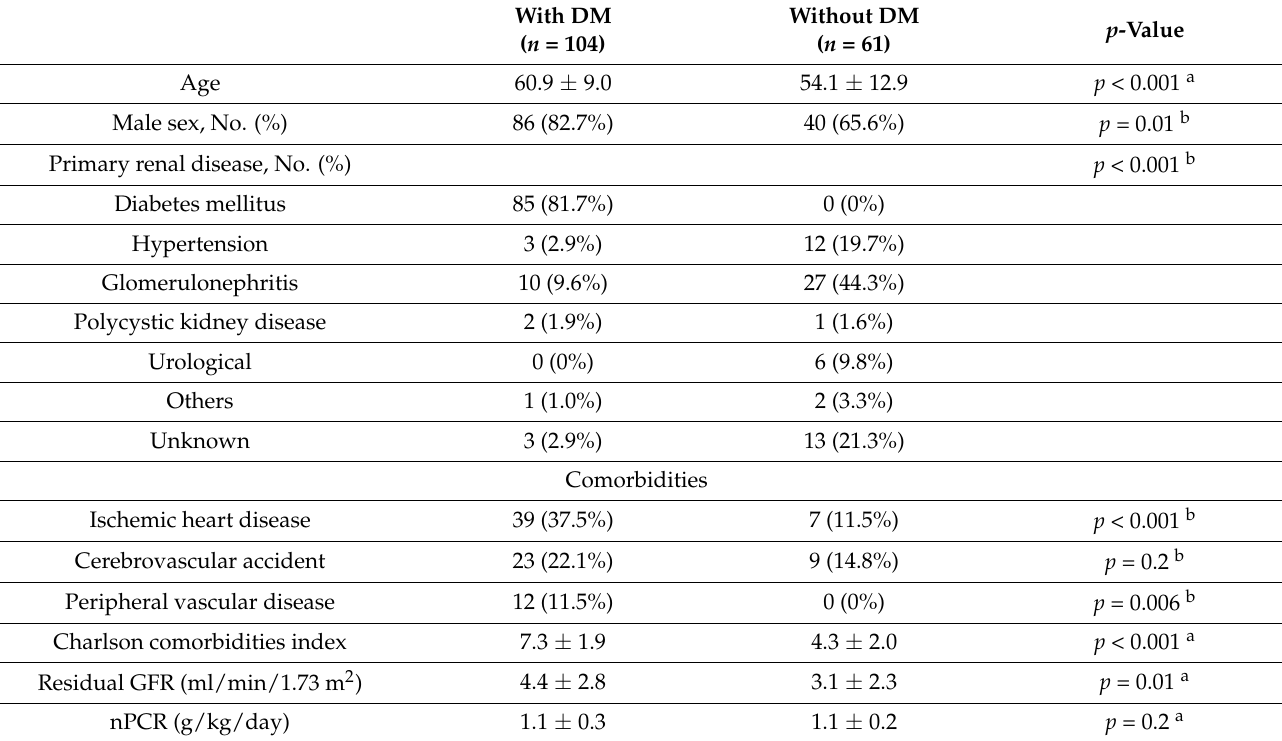
Table 1. Clinical characteristics of recruited